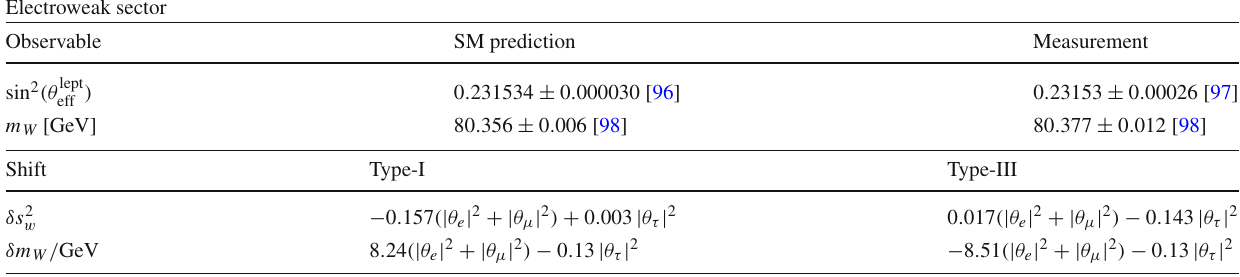
diction for the effective leptonic weak mixing angle is taken from Table II in Ref.[96]. The model predictions are obtained from matching onto SMEFT at the Seesaw scale μ = M X = 1TeV and running to